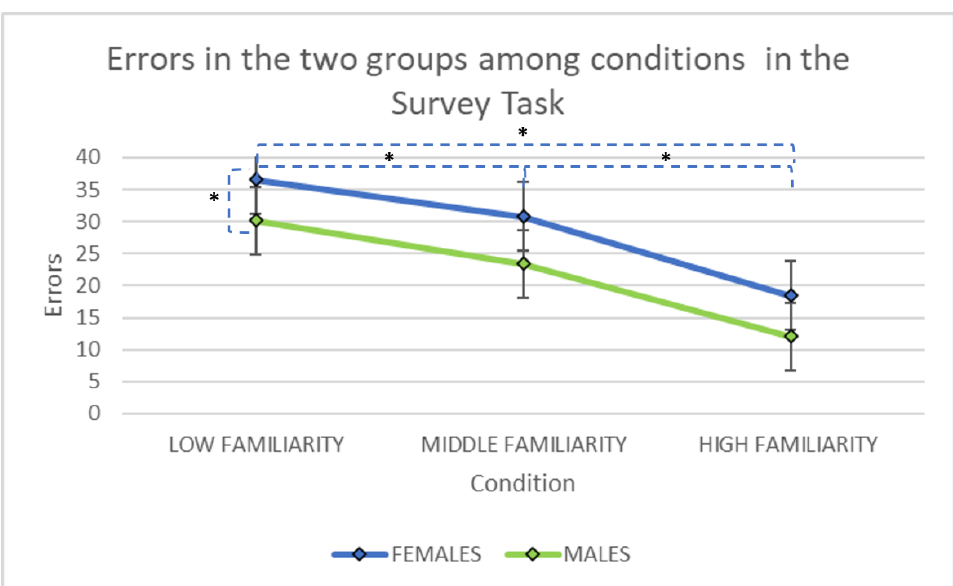
Figure 4. The number of errors made by the two groups (M = male group: blue line; F= female group, green line), among the three conditions (three, five and seven reward boxes) in the Survey task. Asterisks indicate the significant differences between groups or conditions within groups.